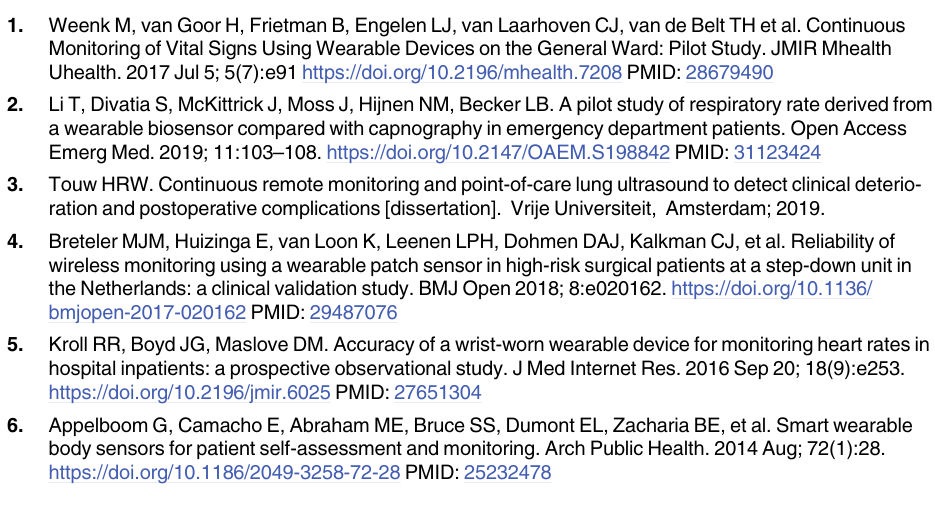
S3 Table. Differences of RespR vitals between patient monitor and Healthdot per patient for a 1-sec-period. Statistics of the RespR vitals per patient on a 1-sec-period. The mean differ- ences are shown in the first column, the CIs are shown in columns 2 and 3. The gray values are the values which exceed the threshold of 5 rpm. S4 Table. Differences of RespR vitals between patient monitor and Healthdot per patient for a 5-min-average. Statistics of the RespR vitals per patient on a 5-min- average. The mean differences are shown in the first column, the CIs are shown in columns 2 and 3. The gray val- ues are the values which exceed the threshold of 5